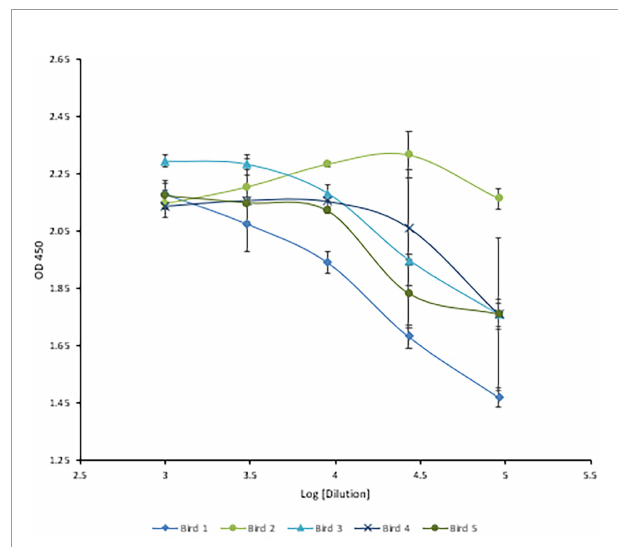
FIGURE 6 | Three-fold serial titration of anti-HRV titers after three immunizations. Titration of hyperimmune anti-HRV serum using a 3-fold serial dilution. An ELISA plate was coated with 10µg/ml of puri fi ed HRV and blocked with 2% BSA in PBS. Serum and yolk antibodies were serially diluted three-fold in PBS containing 2% BSA. HRP-conjugated goat anti-chicken IgY served as the secondary antibody (1:3,000). At 1/91,000 [log (4.95)] the signal from bird #2 was still comparable to the undiluted